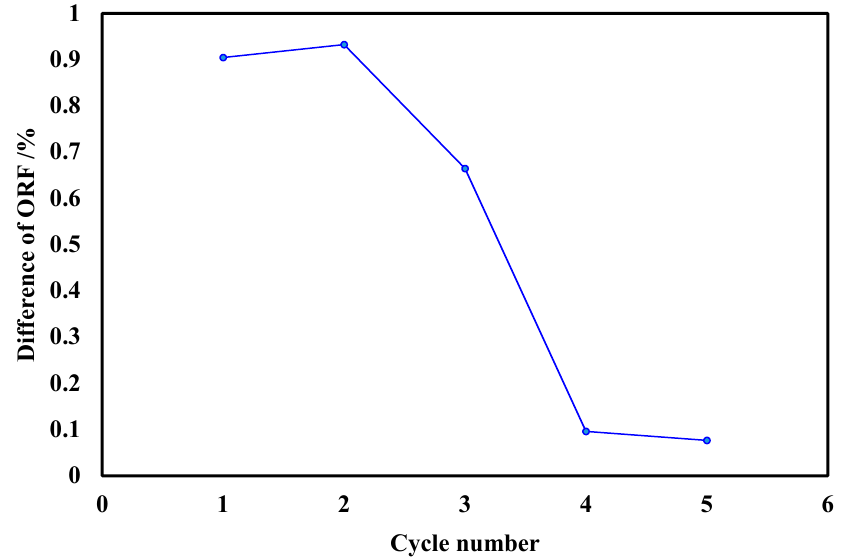
Figure 10. Difference of ORF versus different CO 2 injection cycles.